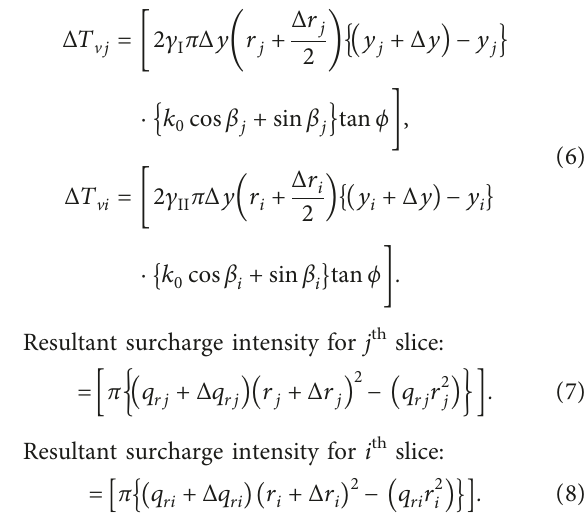
Figure 6: Pictorial view of nonlinear failure surfaces on both the sides of (a) panel 2D:45-0.28-3-(0.39 S (0.47 S II /0.53 S I ), and (c) panel 2D:72-0.38-3-(0.18 S II /0.82 S I